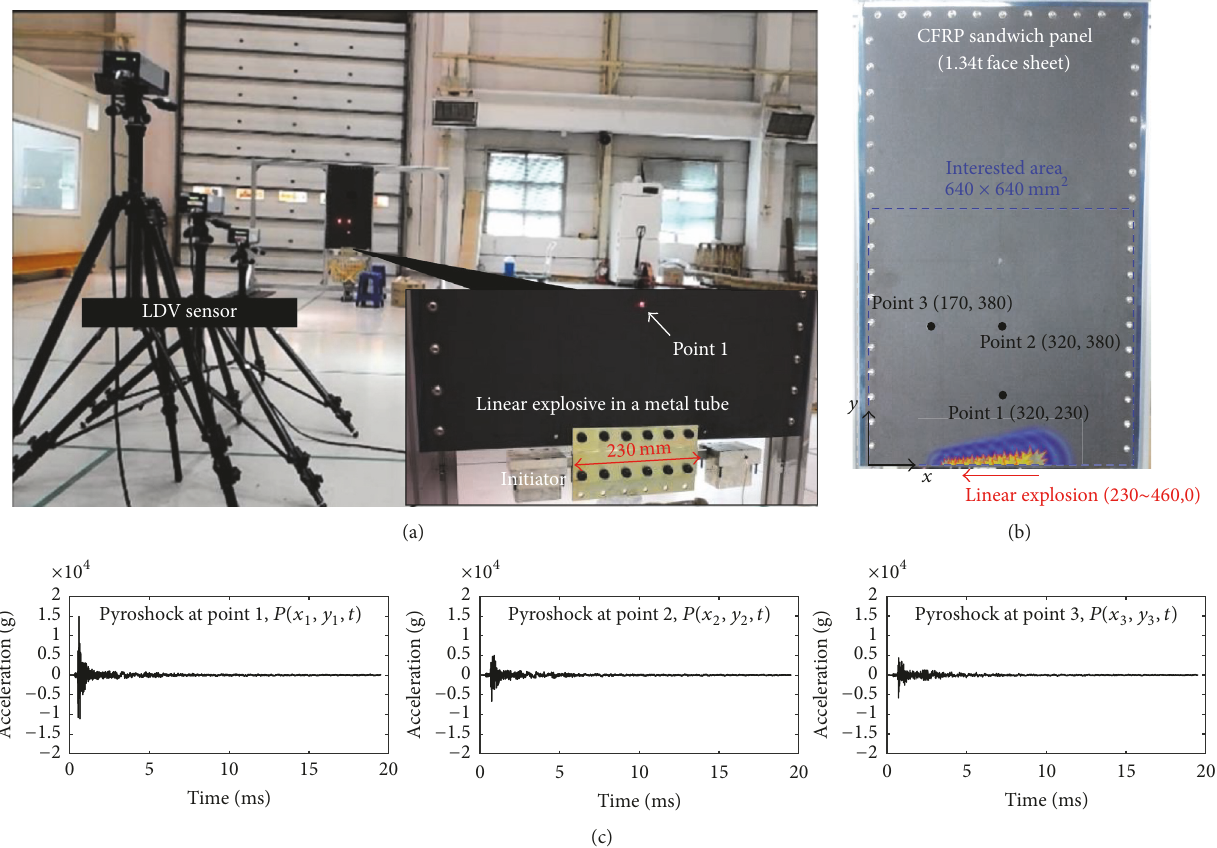
Figure 9: Linear explosive induced pyroshock measurement on the CFRP specimen. (a) Experimental setup. (b) Sensing point on the test specimen. (c) Time domain signal of linear explosive induced pyroshock.